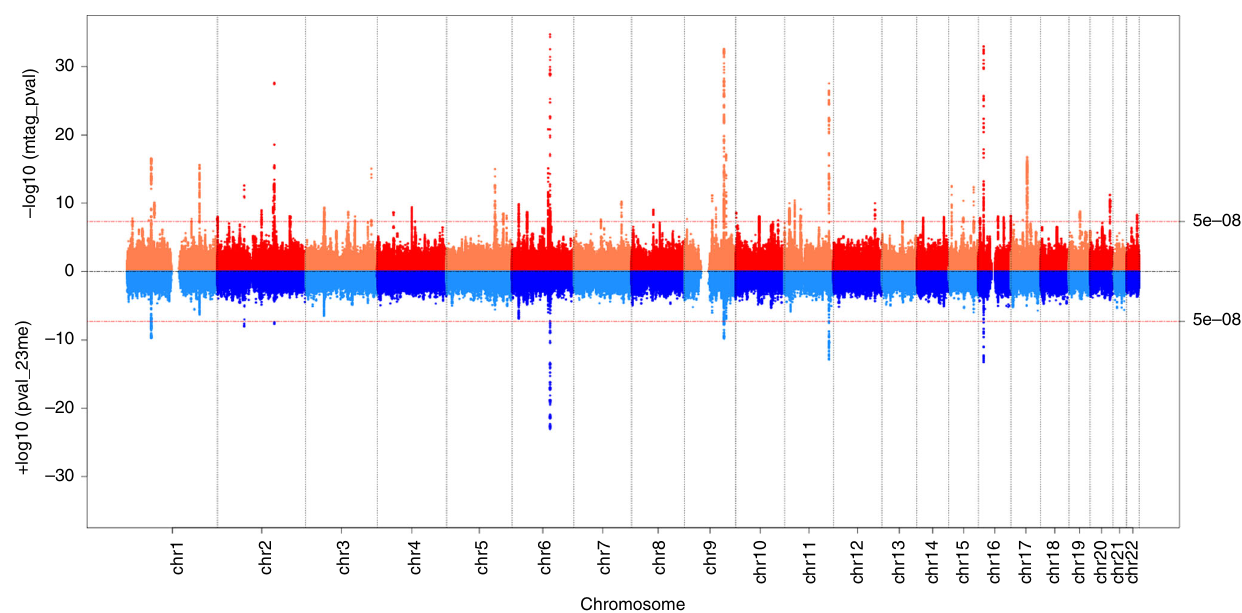
Fig. 1 Miami plot of meta-analysis for age at voice breaking. Miami plot comparing – log 10 ( P values) for SNP associations with age at voice breaking from 23andMe GWAS (bottom half, blue shades) with – log 10 ( P values) from meta-analysis for age at voice breaking combining 23andMe data with UK Biobank study (top half, red shades). Red line indicates genome-wide signi fi cance level ( P < 5 × 10 − 8 ).